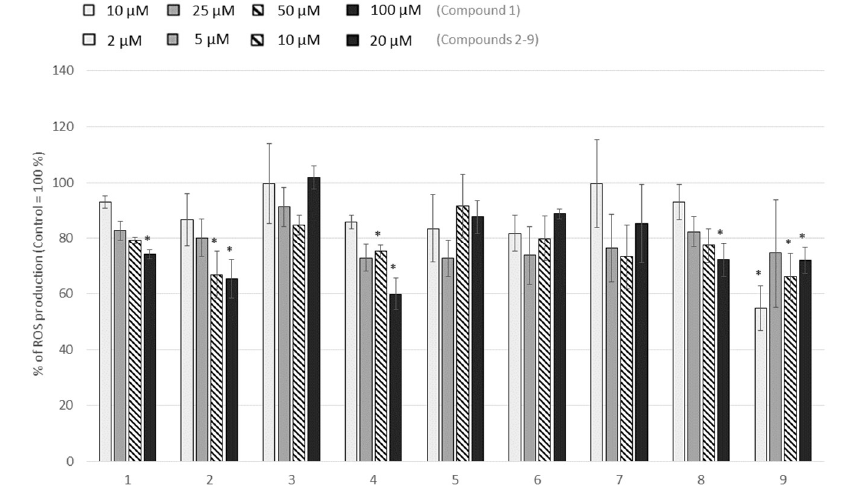
Figure 4. ROS production of blood leucocytes, incubated with the compounds (2, 5, 10 and 20 µ M for compounds 2 – 9 and 10, 25, 50 and 100 µ M for compound 1 ) and stimulated with PMA (1 µ M) for 1 h. Values are expressed as percentage of the control (cells incubated with PMA and without extract). Data are shown as means ± SEM (n = 3); * p < 0.05 compared with Control. All results are expressed as a percentage, with control (i.e., cells with PMA but without extract) normalized as 100%.